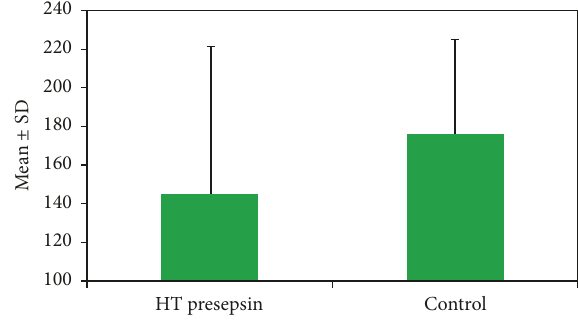
Figure 1: Presepsin levels among